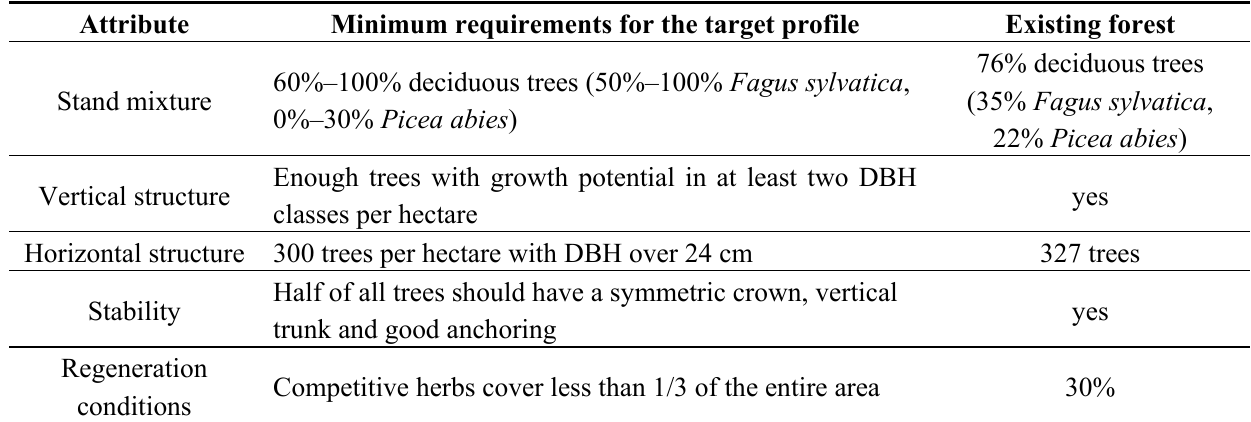
Table 1. Comparison of minimum requirements for the target profile for natural hazard rockfall and alpine mountain Fagus sylvatica forest (site Anemone trifoliae-Fagetum with some narrow area of Ostryo-Fagetum and existing forest stand– sensu